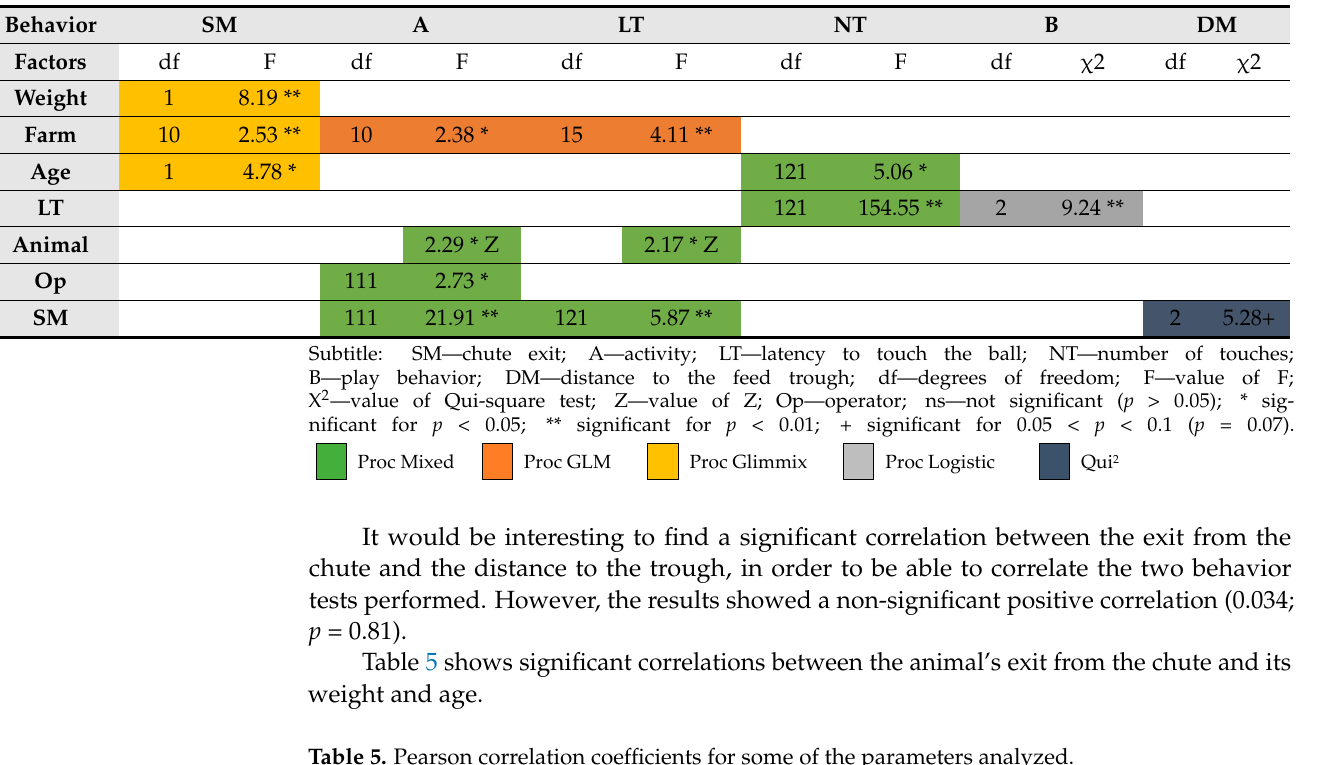
Table 4. Summary of the results of the analysis on the different behaviors according to various models.